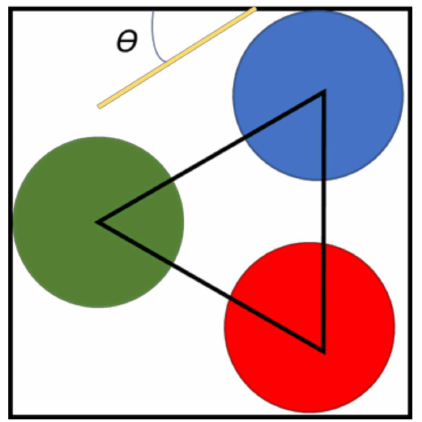
Figure 9. The angular error between the center point of the circle and outermost